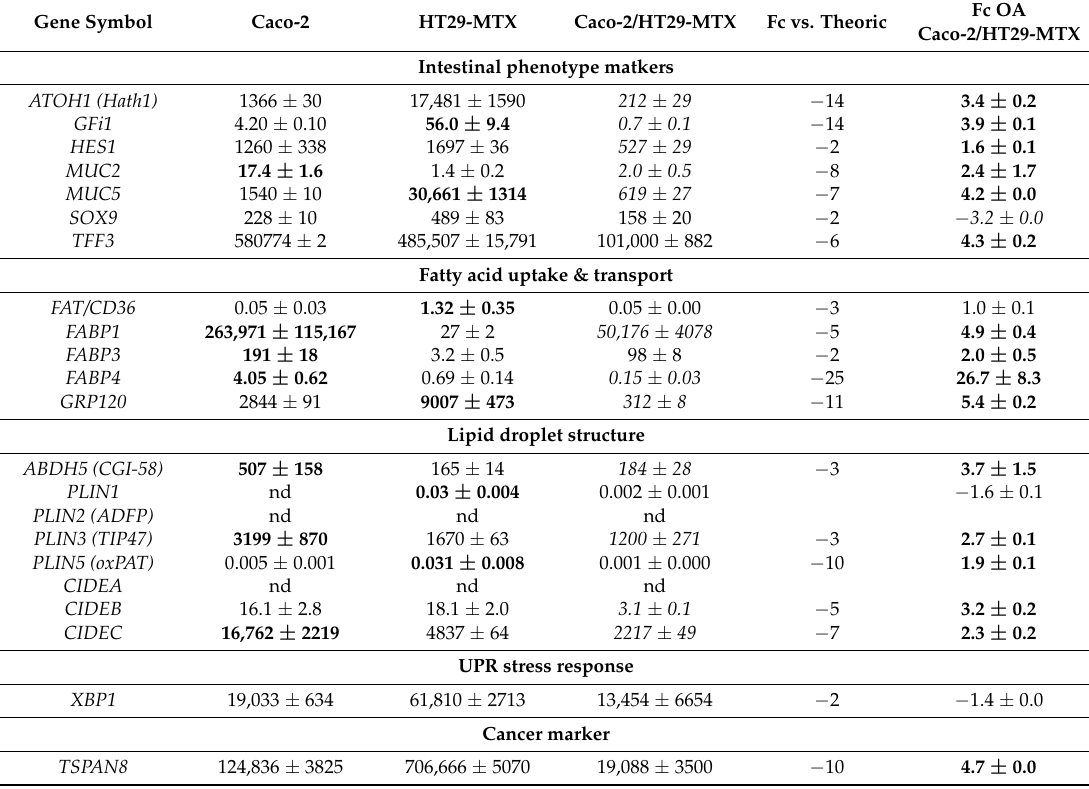
Table 2. Gene transcription analysis of Caco-2, HT29-MTX cells, and co-cultures by qRT-PCR. Fc: fold change (normalized to Hypoxanthine phosphoribosyltransferase 1 HPRT) observed in co-culture versus theoretical (90% Caco-2 + 10% HT29-MTX) or co-cultures treated with oleic acid 60 µ M for 24 h (Fc OA). Bold-type characters: up-regulated, italics: down-regulated; nd: not detected. Data are presented as mean values ± SD ( n =